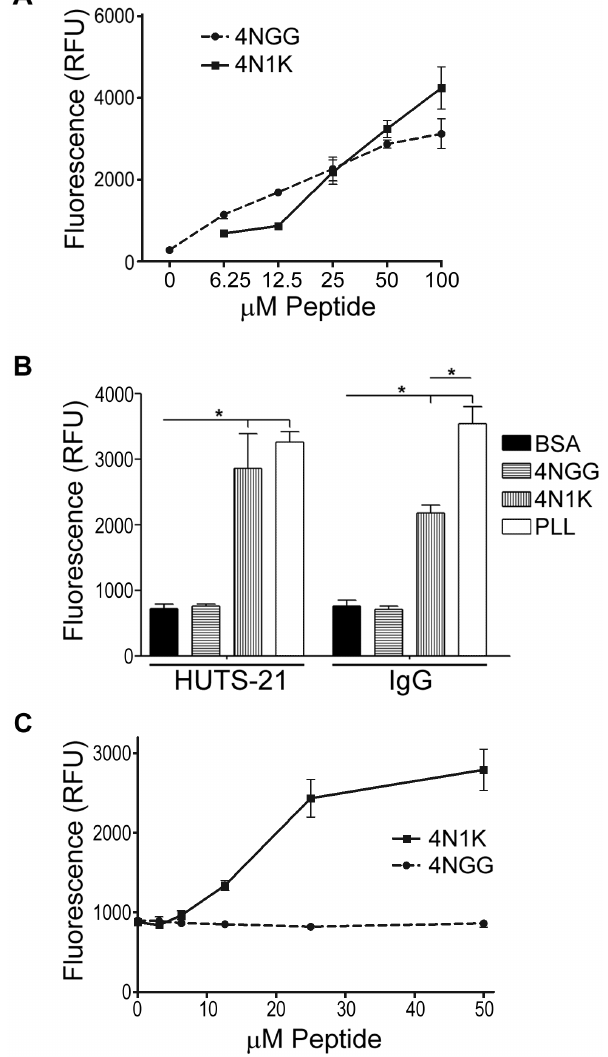
Figure 3. Immobilized 4N1K binds non-specifically to several IgG antibodies. A) Wells of a 96-well dish were coated with the indicated concentrations of peptides and washed with PBS. The amount of adsorbed peptides was quantified using the CBQCA protein assay kit as indicated in methods and materials. The plotted data represent the means 6 standard deviation of three replicate wells of one experiment that is representative of three independently conducted ones. B) HUTS- 21 or an IgG isotype control antibody were added to wells pre-coated with 50 m M 4NGG, 50 m M 4N1K, 50 m M poly-L-lysine, or 1%BSA/PBS. Following washes and incubation with a secondary antibody, bound antibodies were detected using a microplate spectrofluorometer. Data as plotted are the means 6 standard deviation for three replicate samples of one experiment (*, p , 0.05) that is representative of three independently conducted experiments. C) Same as in B) but titrating amounts of 4NGG and 4N1K were adsorbed to wells and only secondary antibodies were added.